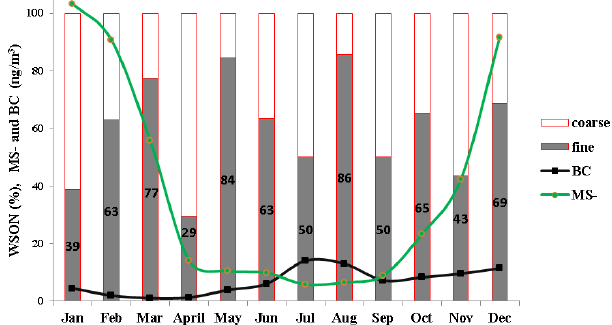
Figure 9. Average monthly concentration of bulk MS − and BC to- gether with the percentage contribution of WSON in fine and coarse mode at Amsterdam Island (Indian Ocean) during 2005.